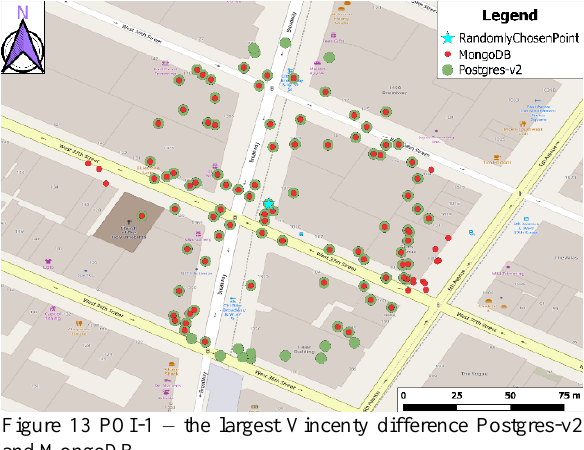
Figure 13 POI-1 – the largest Vincenty difference Postgres-v2 and MongoDB